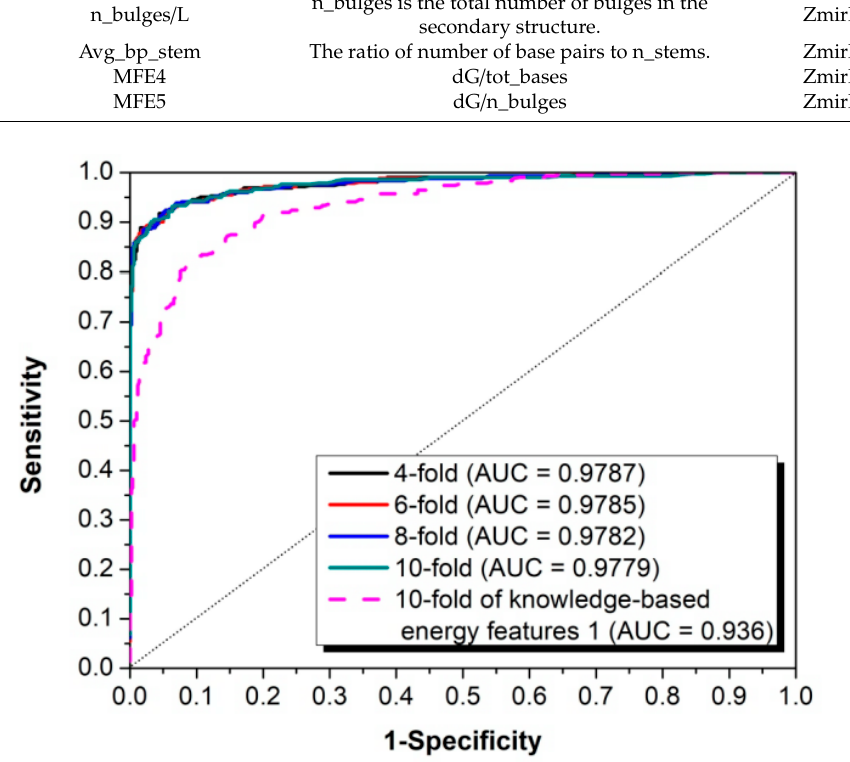
Figure 2. Receiver operating characteristic (ROC) curves from riceMirP prediction performance based on training dataset of riceMirP.